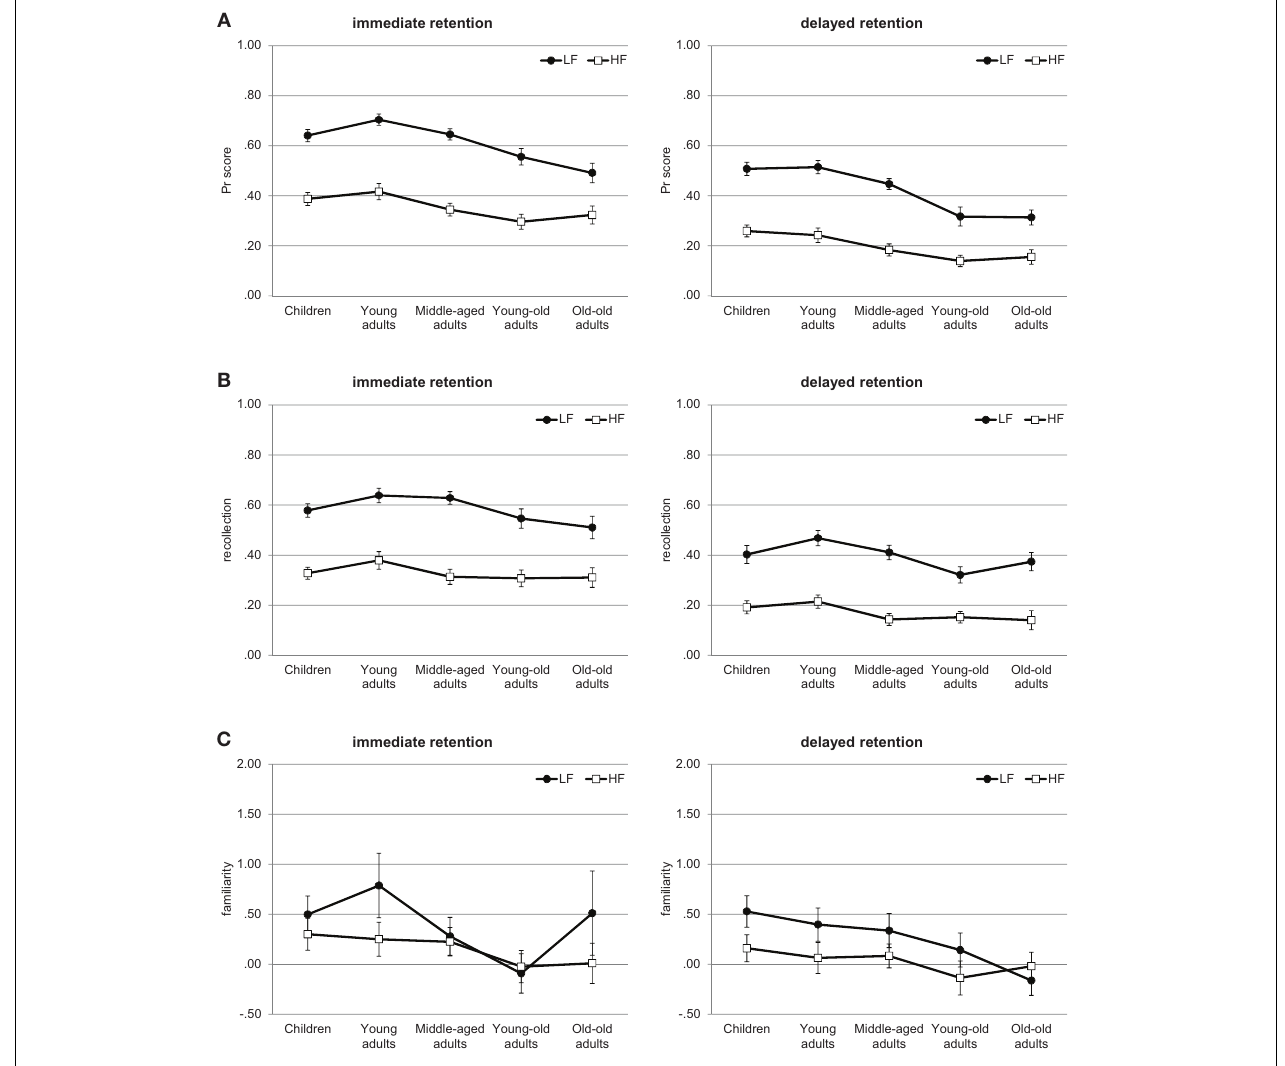
FIGURE 3 | Experiment 3. Recognition memory performance across the lifespan. (A) Pr scores. (B) Estimates of recollection. (C) Estimates of familiarity. Error bars represent standard errors. LF, low-frequency words; HF, high-frequency words.